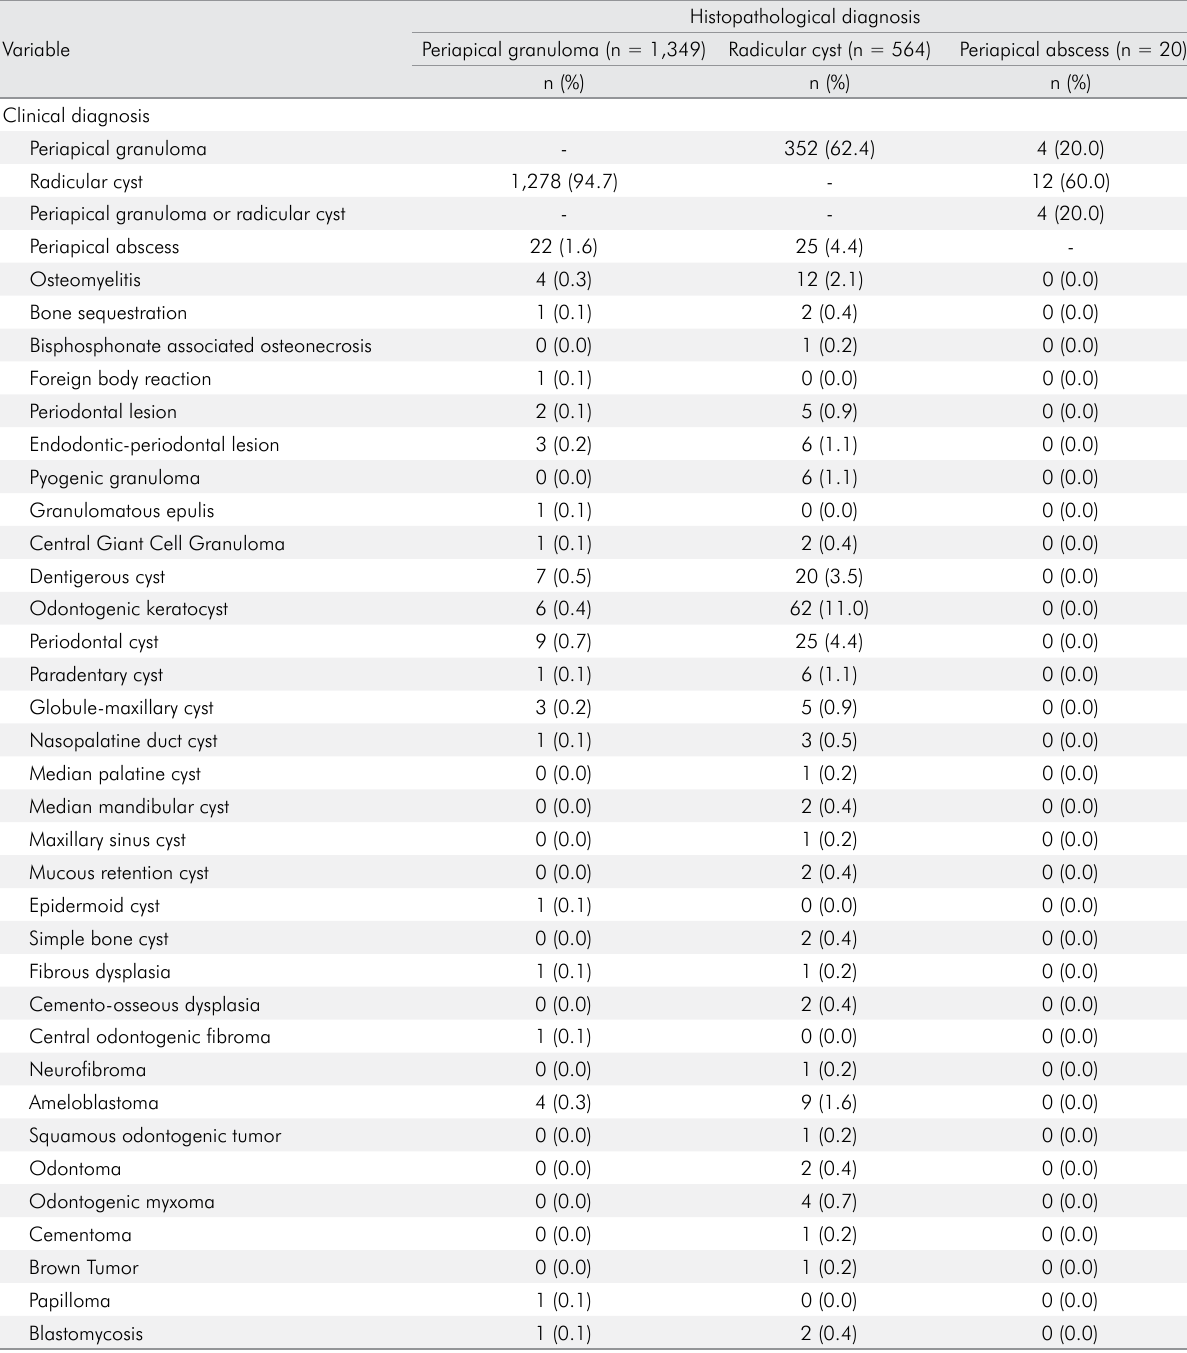
Table 3. Clinical diagnosis of cases with disagreement between the clinical and histopathological diagnosis (n = 1,933).